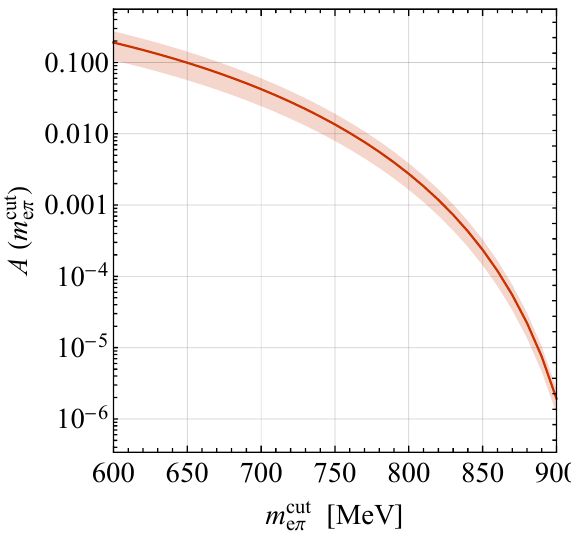
on the invariant mass of eπ